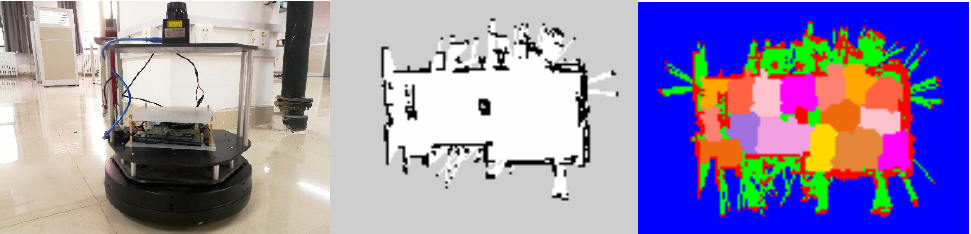
Figure 11. Setup of the turtlebot2 experiments and maps.